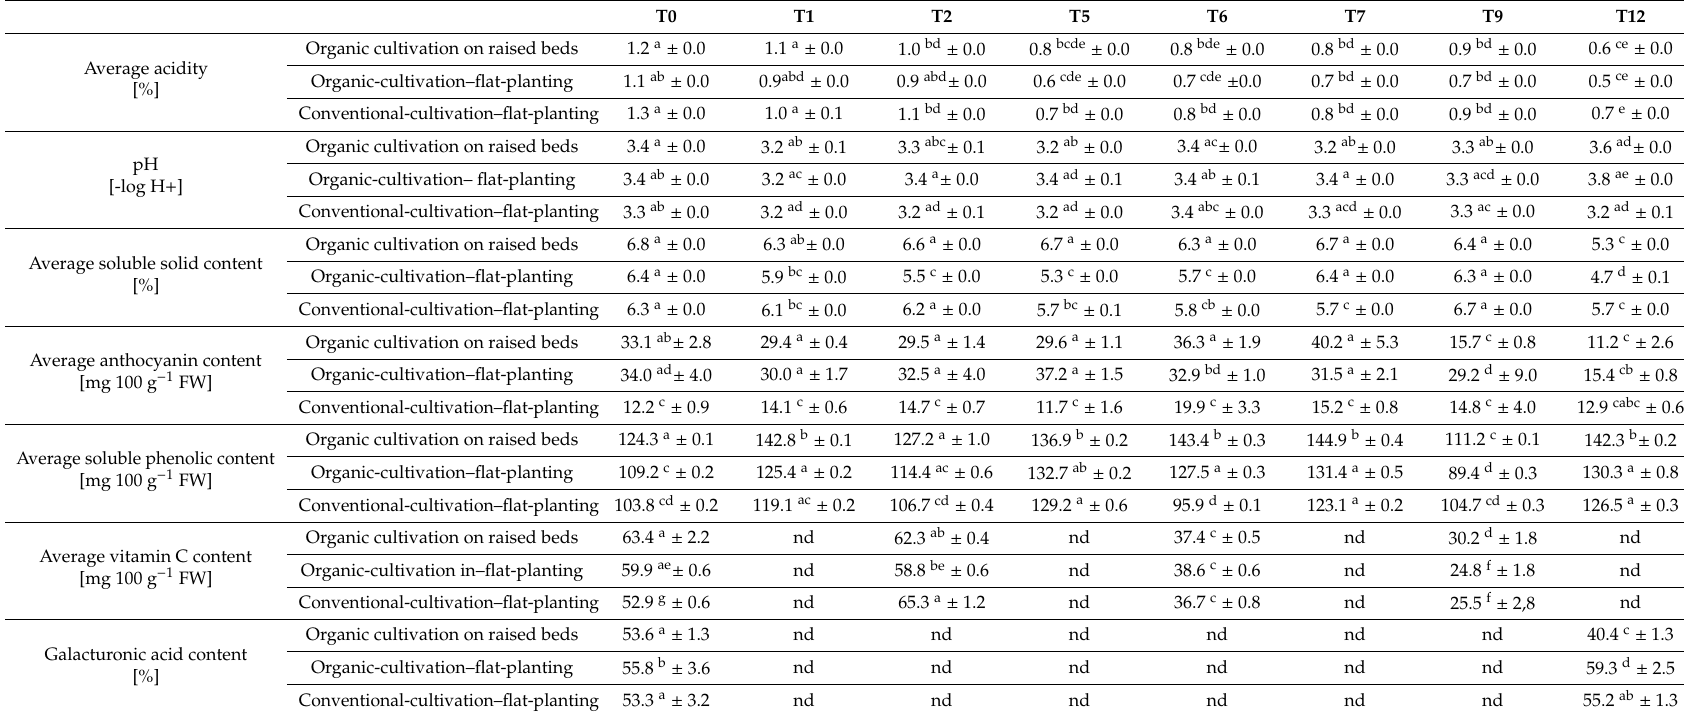
Table 3. Quality results of the strawberries tested. T0—harvest day, T1–T12—days of